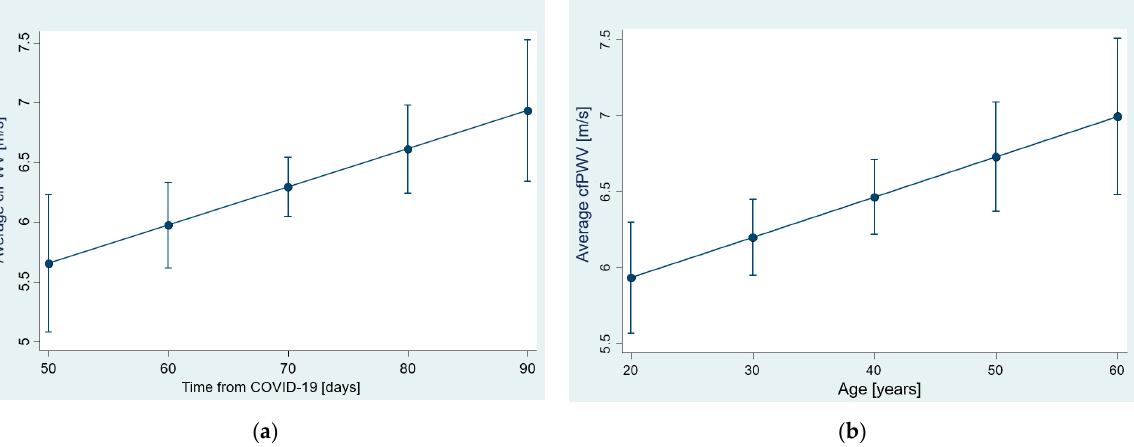
Figure 1. The relationship between the average cfPWV values in the sample and: ( a ) the time since COVID infection; ( b ) age, as estimated with the mixed-effects model (R 2 = 27% at the level of sample, R 2 = 31% for individual changes). Shown are predictive margins of cfPWV values with 95% CIs.